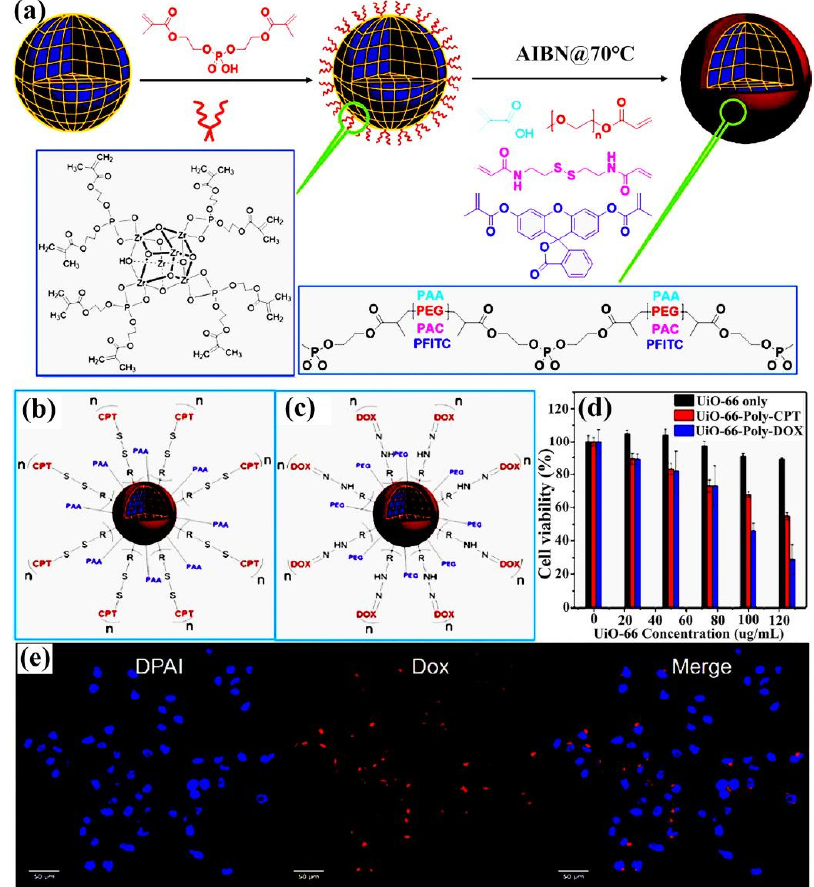
Figure 3. ( a ) Polymer-coated MOFs. ( b ) GSH- and ( c ) acidic pH-responsive drug-delivery systems. ( d ) Cytotoxicity of different materials. ( e ) Confocal imaging of the cancer cell with UiO-66-poly-Dox. Reproduced with permission from Ref. [73], copyright (2019) Wiley-VCH.